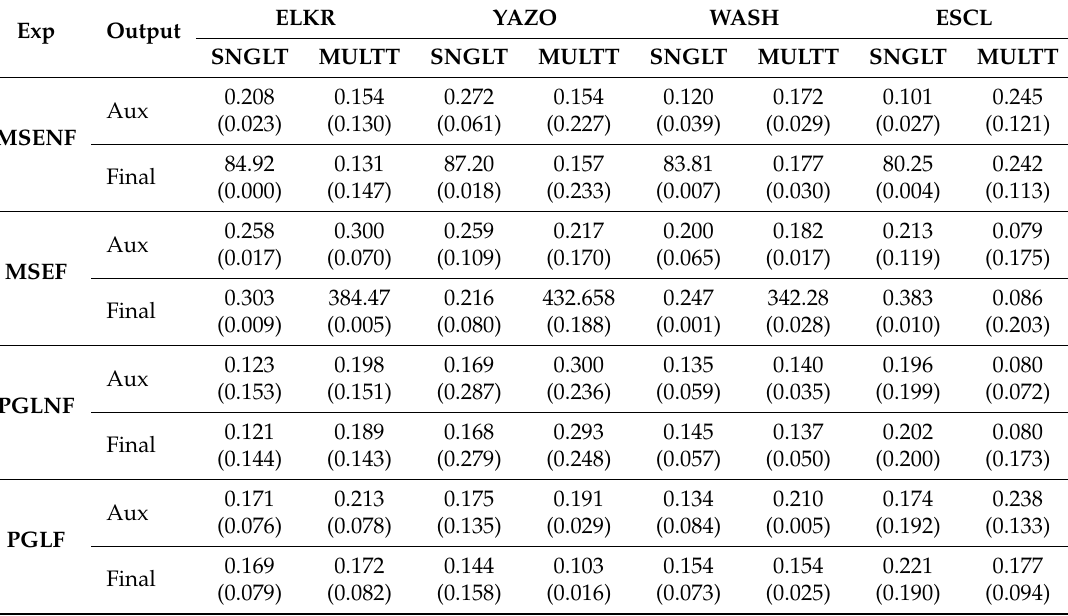
Table 8. Performance metrics for SNGLT and MULTT experiments performed on the prediction time period (TIME_P; 2017–2019) for all experiments: MSENF (MSE loss function, no SAT flagging), PGLNF (physics-guided loss, no SAT flagging), MSEF (MSE loss function, SAT flagging), and